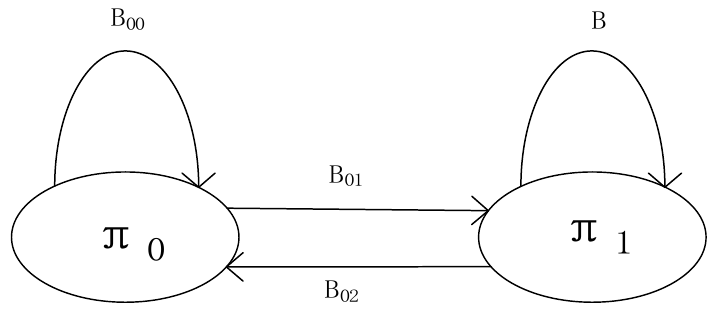
Figure 8. Transfer diagram of the generation and extinction